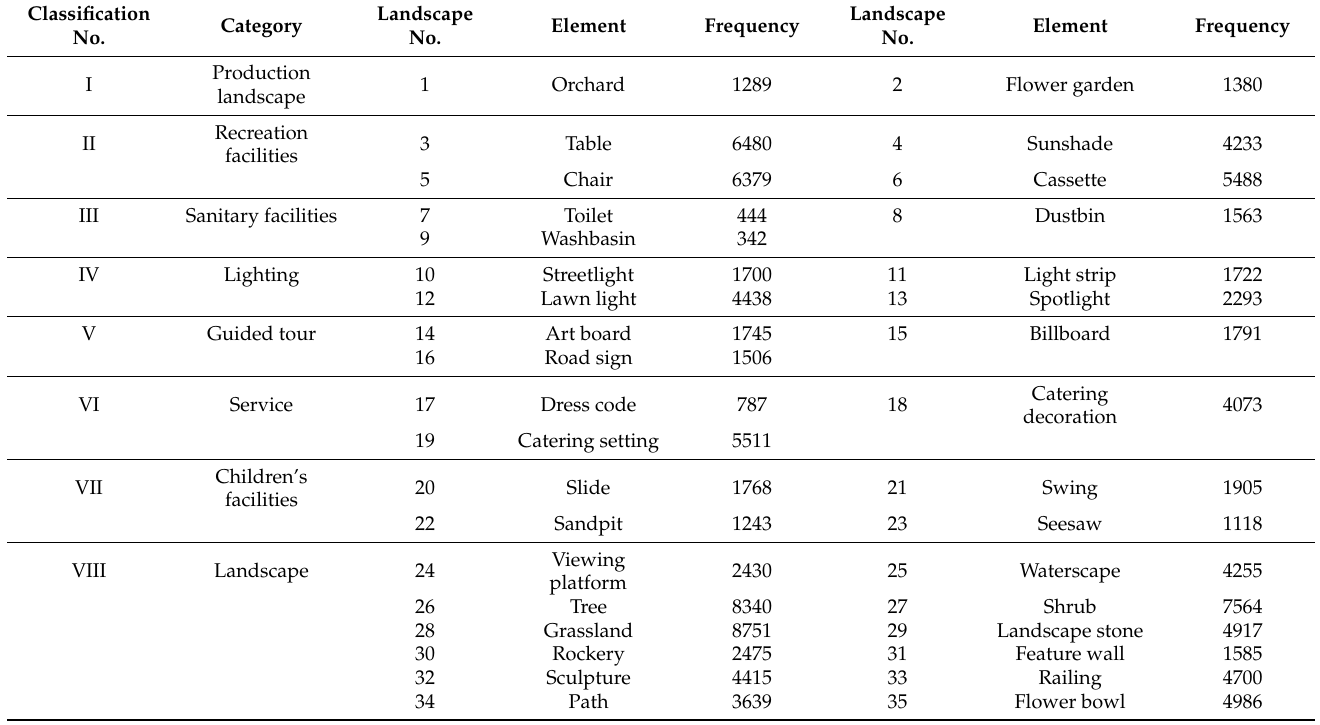
Table 1. Classification of landscape elements of